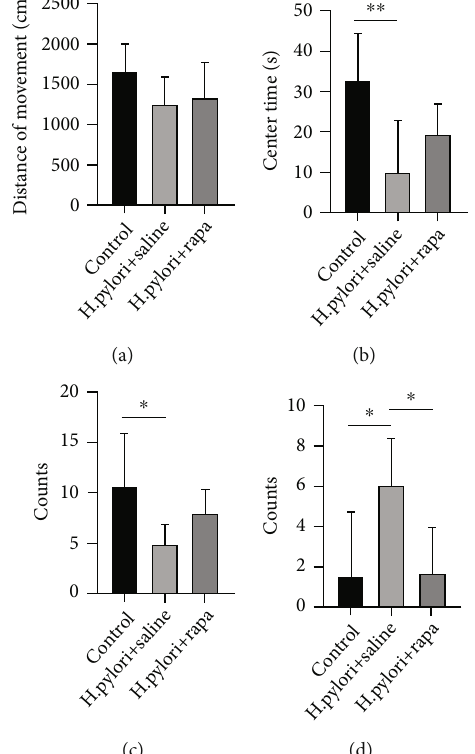
Figure 4: (a) Distance of movement, (b) center time, (c) crossing number, and (d) fecal feces counts of control, H. pylori+saline, and H. pylori+rapa groups. ∗ P < 0 : 05, ∗∗ P < 0 : 01, and ∗∗∗ P < 0 : 001 versus respective